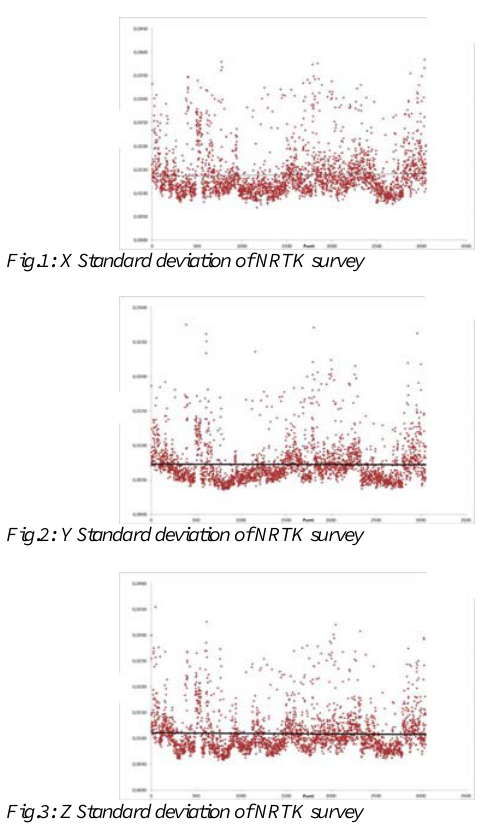
Fig.3: Z Standard deviation of NRTK survey